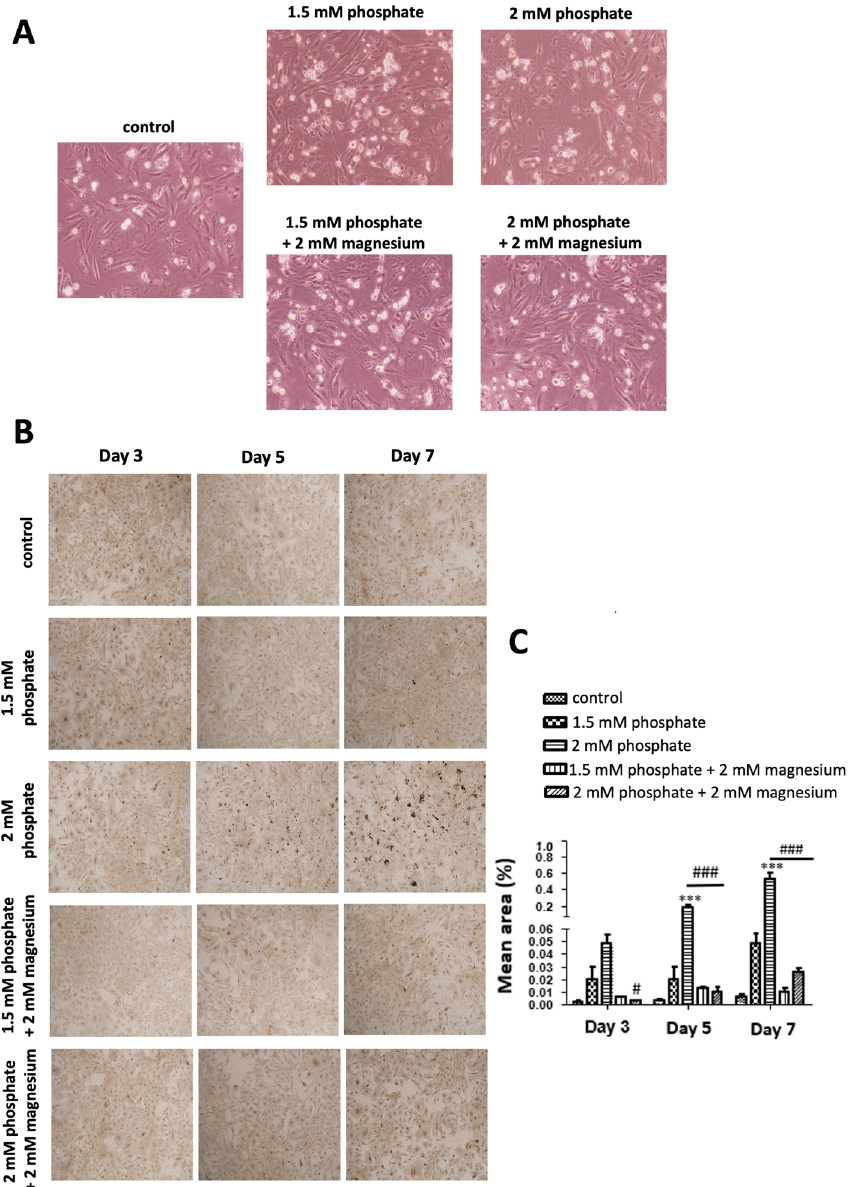
Figure 2. Effects of phosphate and magnesium on DolKT-1 cell calcification. Morphological features of cells exposed to 0.9 mM phosphate and 0.8 mM magnesium (control), 1.5 mM phosphate, 2 mM phosphate, 1.5 mM phosphate + 2 mM magnesium, and 2 mM phosphate + 2 mM magnesium ( A ). The images were taken after 72 h of exposure. Magnification, × 42. Von Kossa staining shows calcium deposition in each experimental group at 3, 5, and 7 days of exposure. Images are representative of three separate experiments ( B ). Quantitative analysis of Von Kossa staining was performed using morphometric analysis by Image J (Image J bundled with 64-bit Java 8; https:// imagej. nih. gov/ ij/ downl oad. html? fbclid= IwAR0 60tXk lMhoV owfvH zwq9s NxID7_ IkQBr PxqD6 Ej4fN 68jql GbYma 40eFc) on the pooled results of three separate experiments ( C ). n = 4 for each group in each culture condition. ***P < 0.001 vs. control; # P < 0.05, ### P < 0.001 vs. 2 mM phosphate, respectively. DolKT-1 cells Dolphin proximal tubular